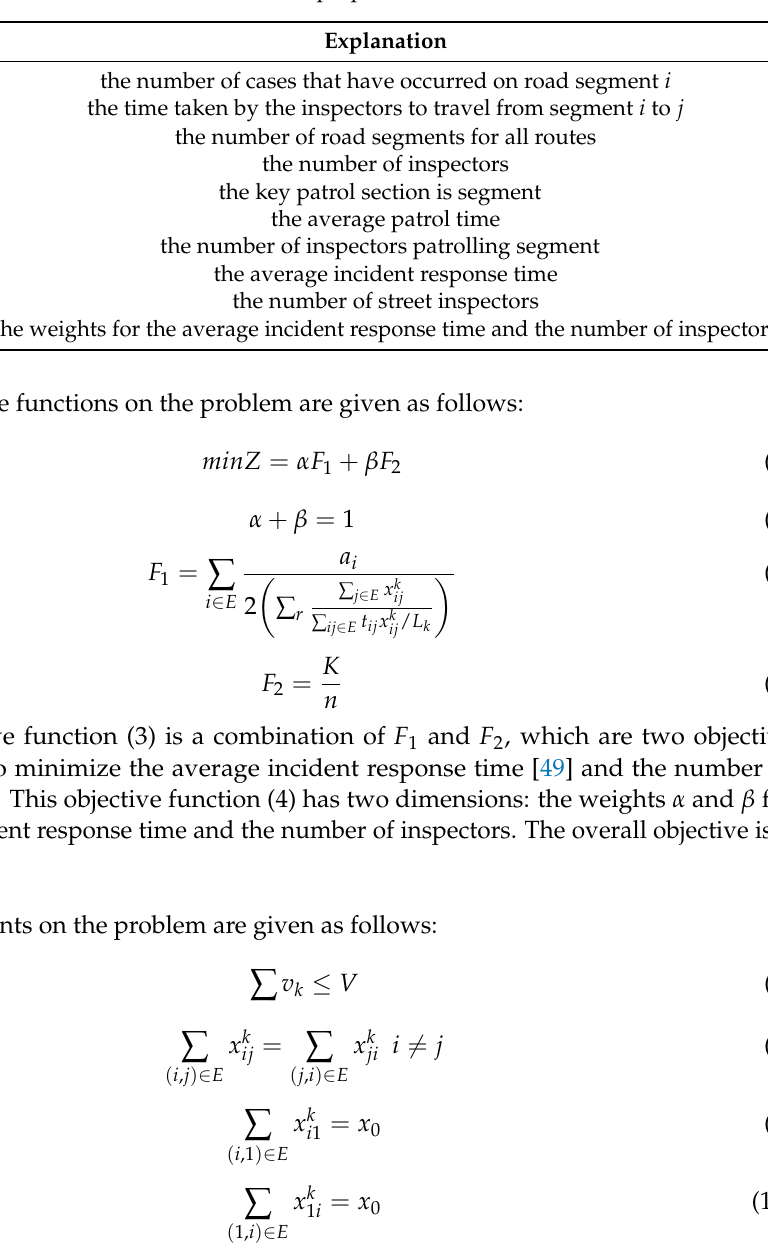
Table 1. List of mathematical notations used in the proposed